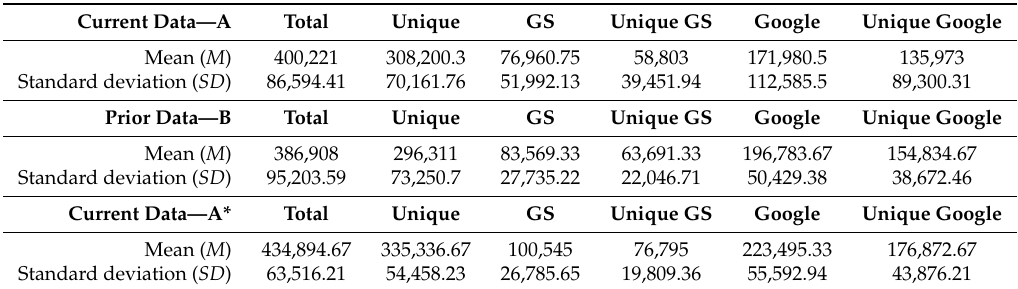
Table 3. Measures of central tendency for total and unique web traffic to Strathprints during Y1–Y4 (‘Current data—A’), alongside total and unique traffic referred via Google and Google Scholar (GS). Data also include measures for ‘Prior data—B’ using data reported in [8] for comparison. Bottom row, ‘Current data—A*’, are ‘Current data—A’ data excluding outlying Y1